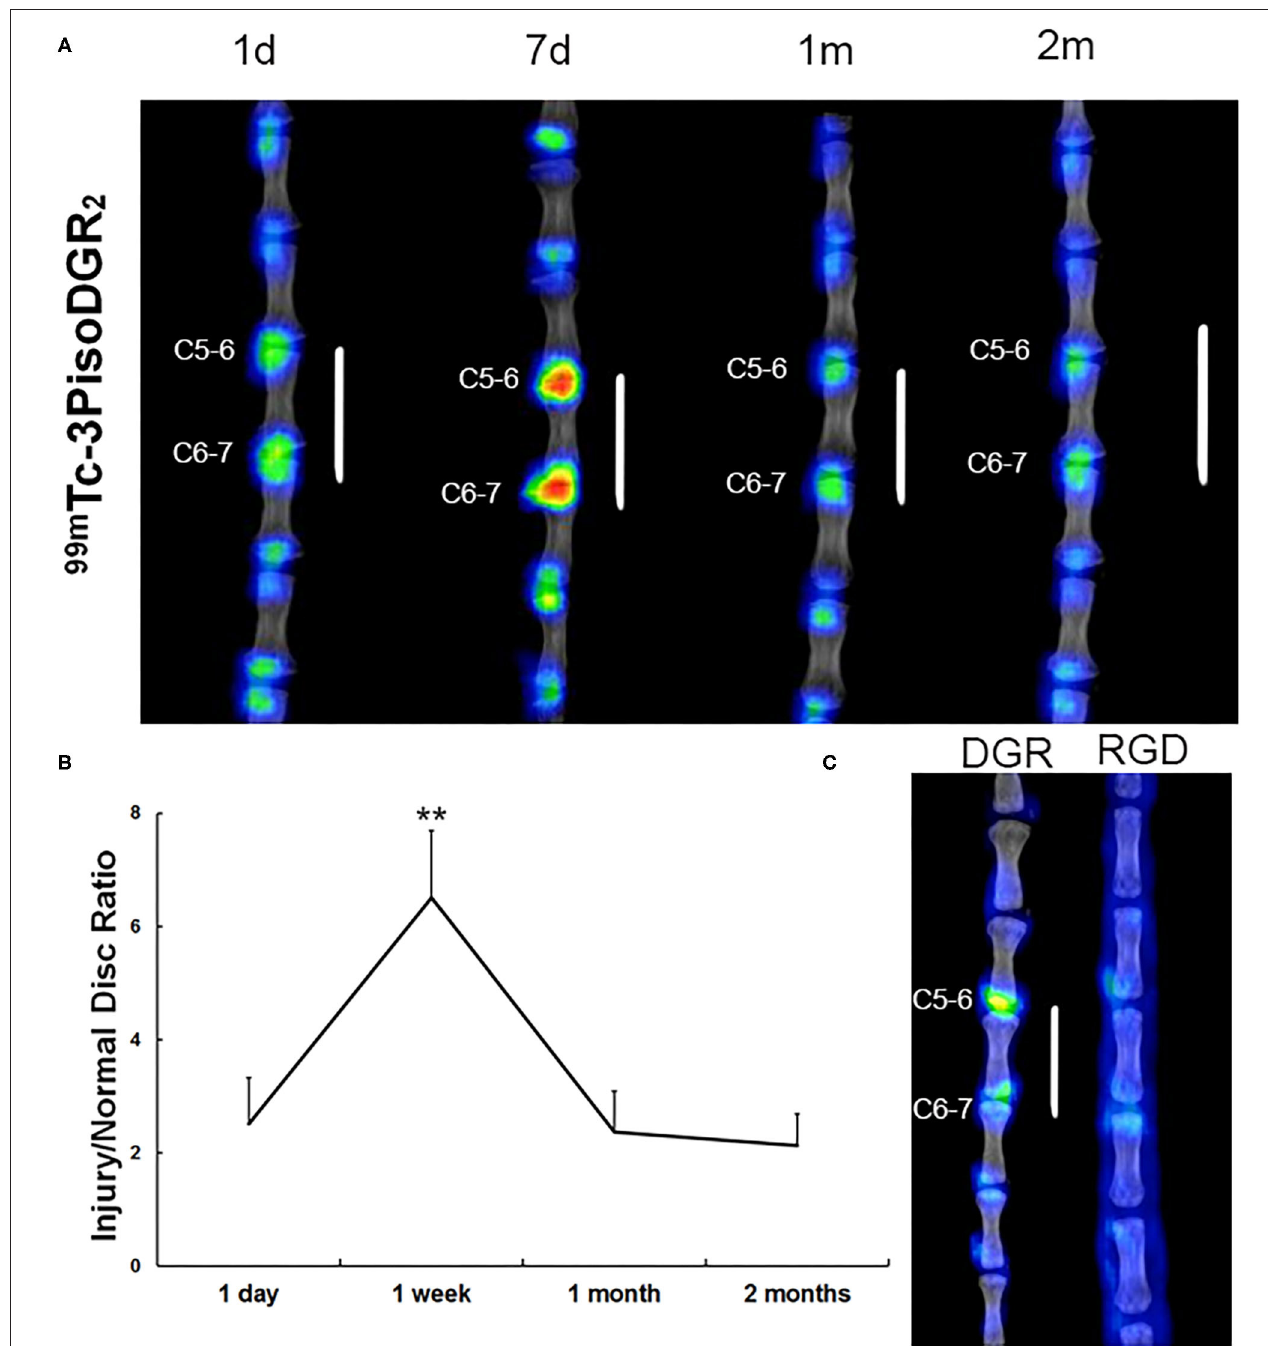
FIGURE 2 | Representative SPECT images in the caudal spine at 1 day, 7 days, 1 month, and 2 months postinjury. (A) Radioactive signal accumulation was revealed in the punctured disc area of the injured disc at 1 day postinjury. The radioactivity peaked at 1 week and remained at a higher level until 2 months postinjury. A small amount of radioactivity was found in normal disks. (B) The radioactivity of the disc injury region in vivo was plotted against the post probe injection time. ** p < 0.01 compared to injured disks at 1 day, 1 month, and 2 months. (C) To validate the specificity of 99m Tc-3PisoDGR2 for integrin α 5 β 1, we conducted 99m Tc-RGD imaging in a rat model of disc herniation. 99m Tc-RGD is the specific probe for integrin α v β 3, which was intravenously injected into the injury group ( n = 2) on day 7 postinjury. The experimental process was the same as before. Almost no focal signal was observed in the corresponding region relative to the normal disc of the RGD group.